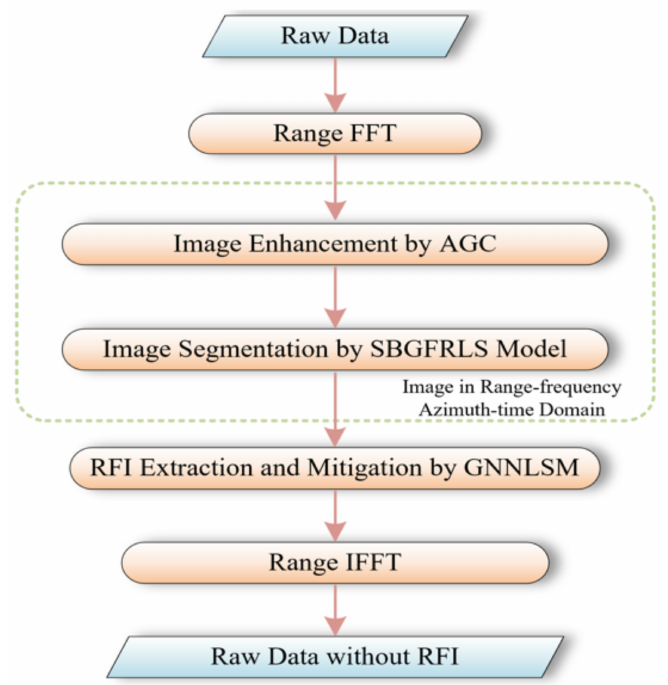
Figure 4. Flowchart of the proposed